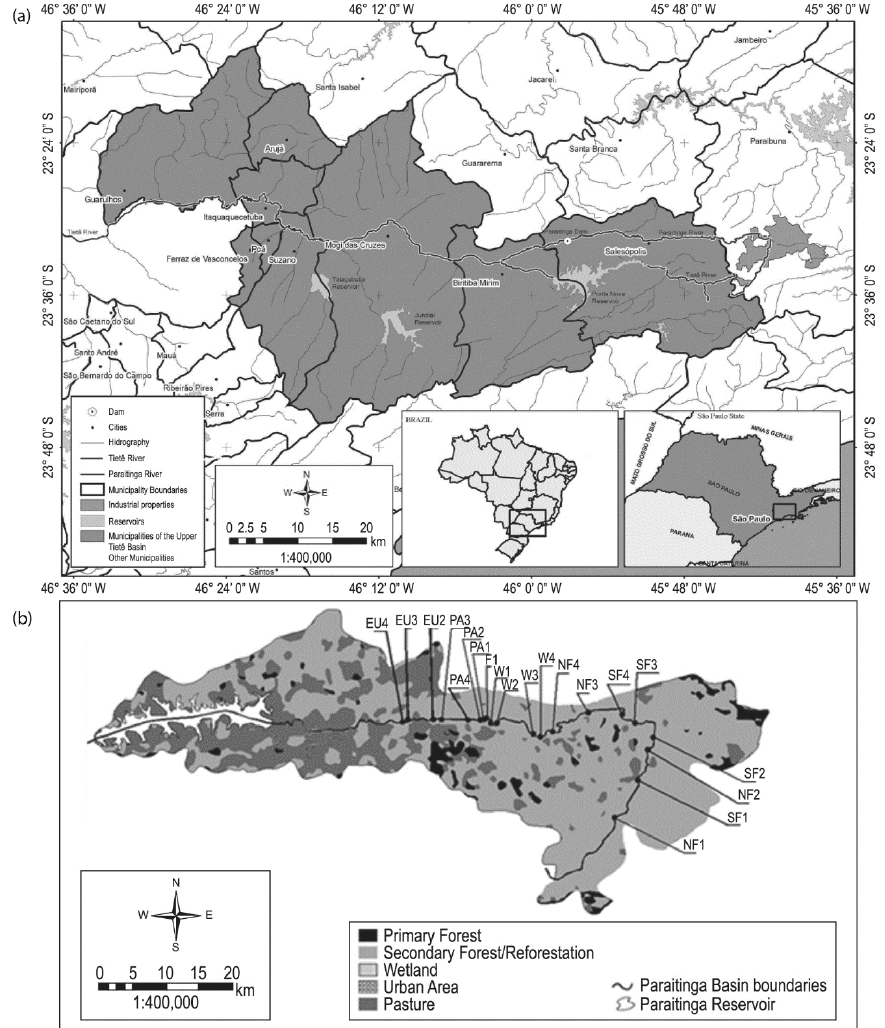
Figure 1. Location of Paraitinga River in Tietê-Cabeceiras sub-basin, Upper Tietê River Basin (a), and major land uses in Paraitinga watershed, indicating the sampling sites from upstream to downstream (b). SF = secondary forest; NF = native forest; EU = eucalyptus; PA = pasture; W = waterfalls (Esteves et al.,